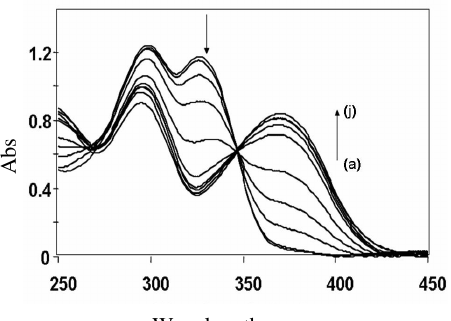
Figure 1. Electronic spectra of 1a (5.2 x 10 -5 M) in aqueous buffers of pH (a) 1.2, (b) 2.8, (c) 5.8, (d) 6.8, (e) 7.75, (f) 8.5, (g) 9.7, (h) 10.8, (i) 11.4 and (j)